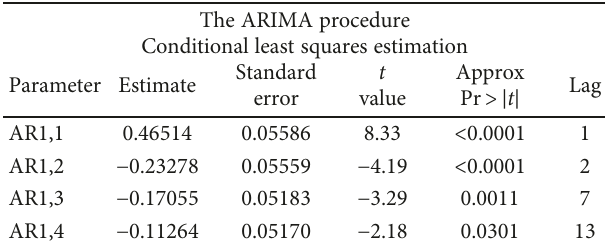
Table 1: Parameter estimates for rice prices. The ARIMA